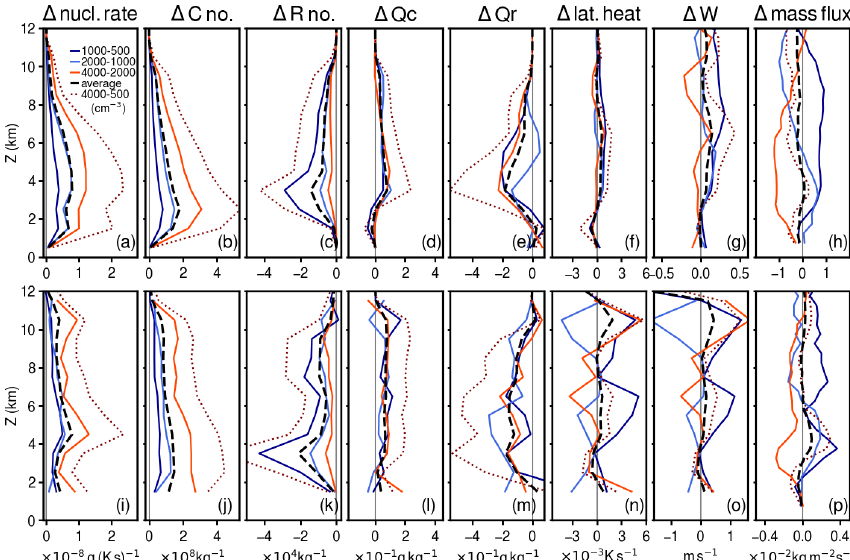
Figure 5. Differences between vertical profiles in Fig. 4, corresponding to each doubling of aerosol number concentrations (continuous colored lines), their average change (dashed black line), and the change between the two extreme cases, i.e., 4000 and 500cm − 3 (dotted line). Top panels (a–h) correspond to cloudy updraft grid points and lower panels (i–p) to tracked thermals. Note the different scales used for vertical velocity and for mass